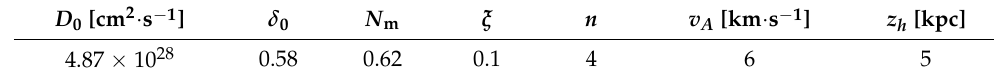
Table 1. Transport parameters of SDP model.